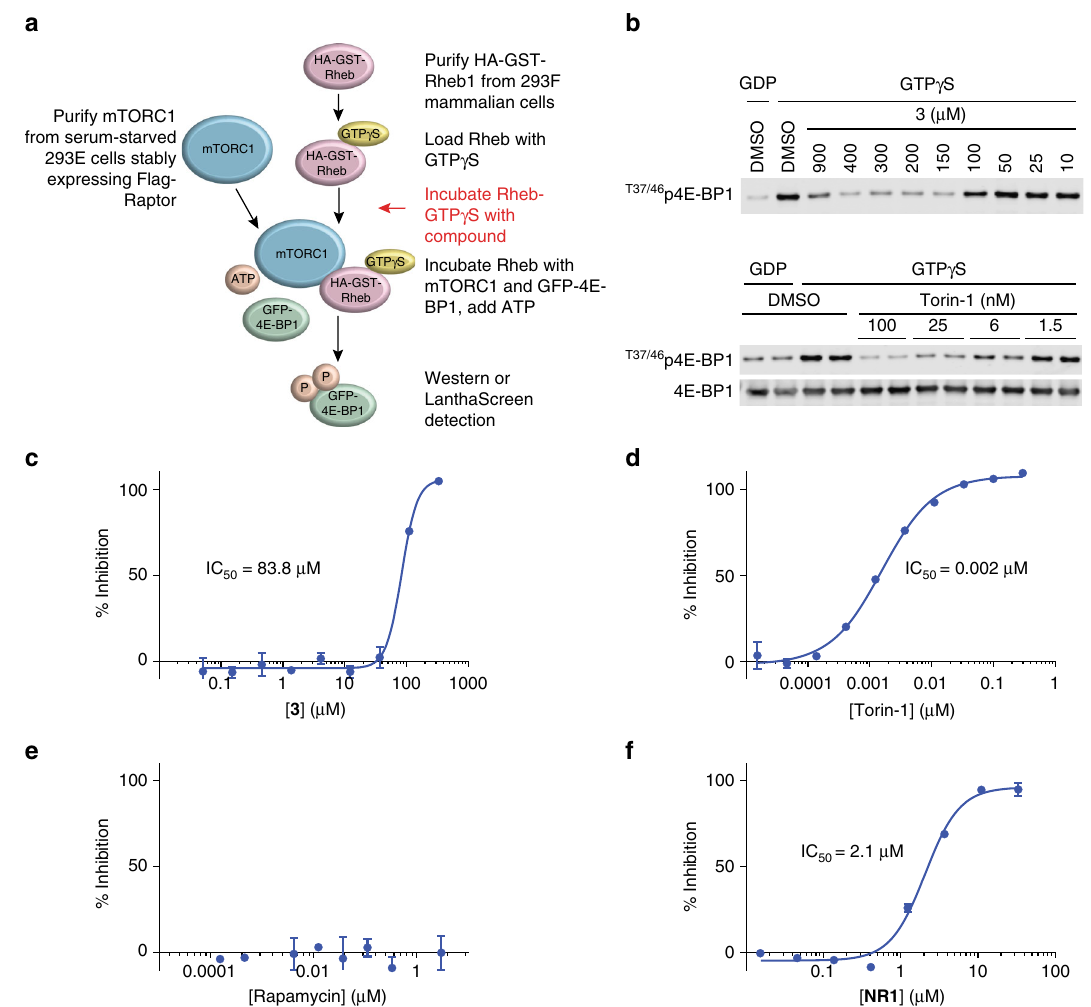
Fig. 2 Rheb-binding compounds inhibit mTORC1 activity in vitro. a Schematic of Rheb-IVK (described in Methods section). b Evaluation of 3 and Torin-1 in the Rheb-IVK assay using Western blot analysis. Rheb-IVK reaction mixtures were incubated with either 3 or Torin-1 at the indicated doses, run on Western blots, and probed with T37/T46 p4E-BP1-speci fi c antibody. c – f Evaluation of 3 , Torin-1, rapamycin, and NR1 in Rheb-IVK. The assay was run similar to the Western blot but processed in a LanthaScreen format using a Terbium labeled T46 p4E-BP1 antibody. Error bars represent standard deviation from the mean of technical duplicates; graphs represent data from one of at least three separate